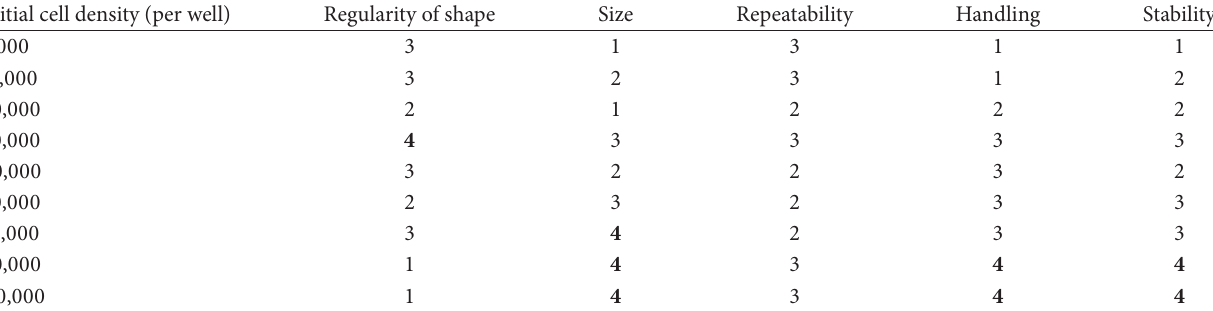
Table 2: Scores obtained in the qualitative assessment for the different cell densities. Initial cell density (per